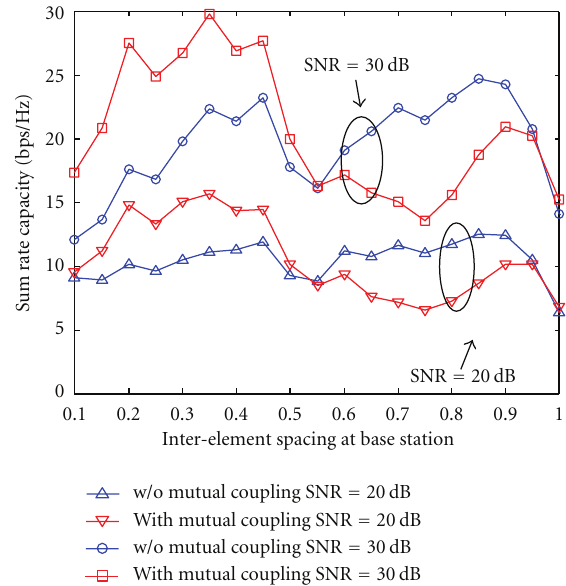
Figure 1: Sum rate capacity with regards to interelement spacing at BS for a 2 × (3 × 6) multiuser MIMO system with and without mutual coupling taken into account.